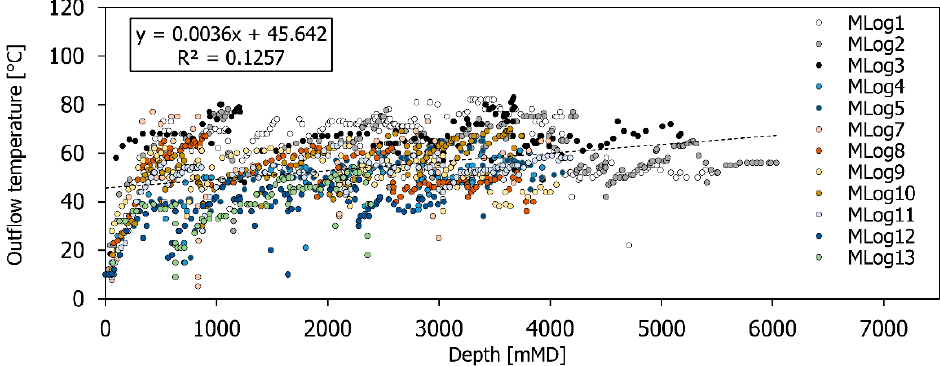
Figure 5. Outflow temperatures from mud logs in the Bavarian Molasse Basin. The different colors represent 13 different wells.